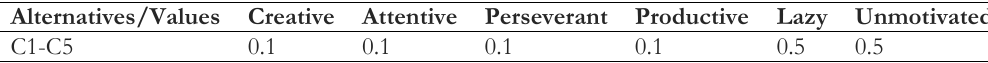
Table 18. The matrix of weights for the second sensitive analysis.